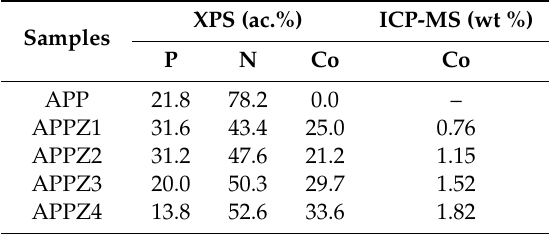
Table 1. Surface relative atom concentration of element and bulk element content.